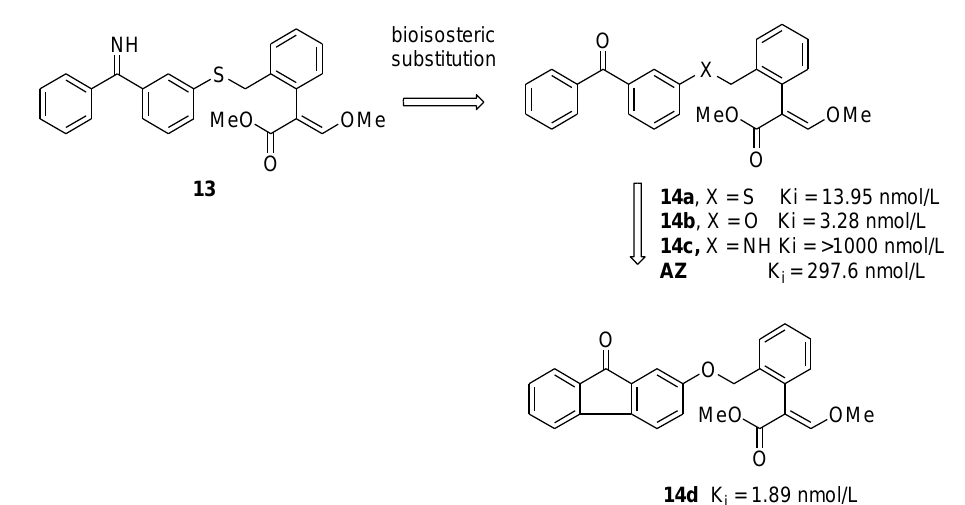
Figure 4. Structural optimization of lead compound 13 and inhibitory activities of representative compounds 14a – 14d and azoxystrobin (AZ) against porcine SCR (succinate cytochrome c reductase) with cytochrome c as substrate.